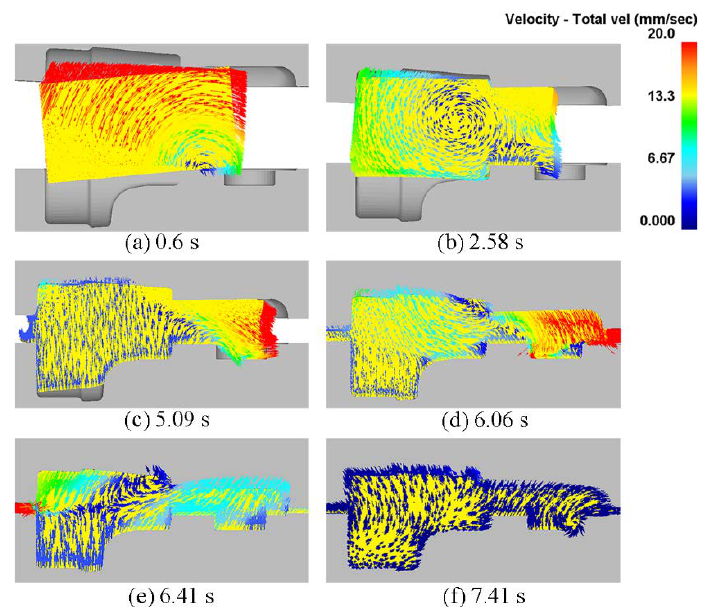
Figure 12. Distribution of velocity field with forming time as blank length of 58 mm during cold orbital forming: ( a ) t = 0 s; ( b ) t = 2.58 s; ( c ) t = 5.09 s; ( d ) t = 6.06 s; ( e ) t = 6.41 s; ( f ) t = 7.41 s.